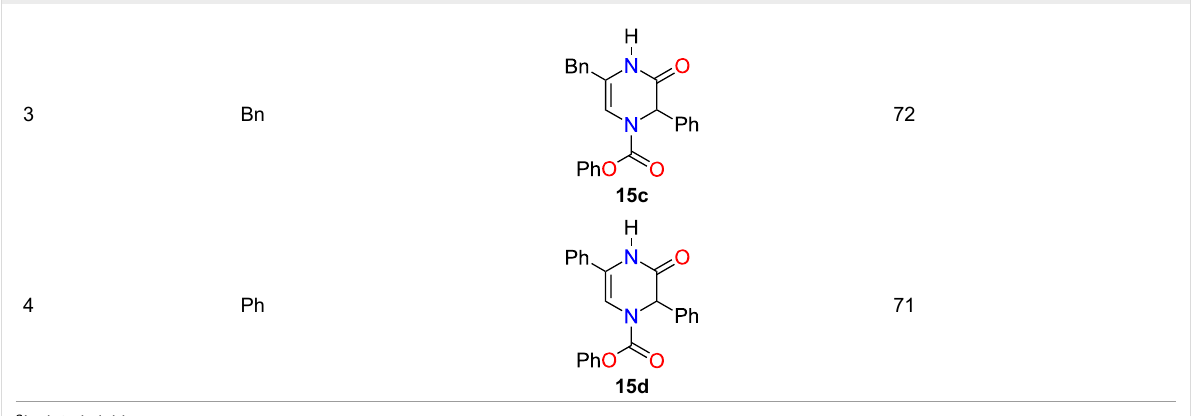
Table 3: One-pot synthesis of substituted Δ 5 -2-oxopiperazines.